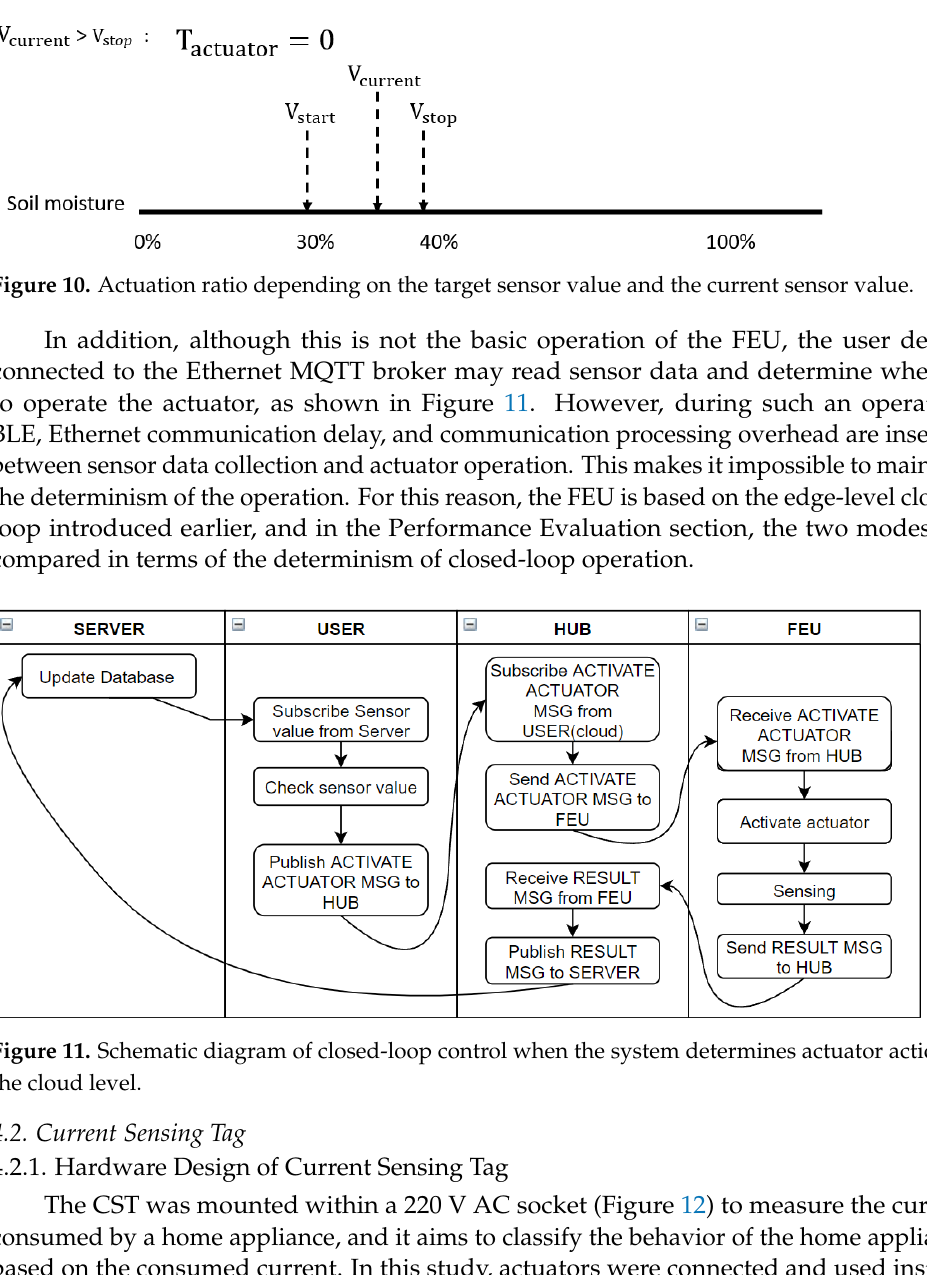
Figure 12. current sensing tag board. There are three types of ACS-712 [17] current sensors (5 A, 20 A, 30 A), and the cur- rent sensor ACS712ELCTR-20A-T used herein is the 20 A model. This model was selected because home appliances usually consume more than 1100 W (5 A); for instance, several types of heaters such as irons, coffee pots, and electric stoves (more than 1500 W).